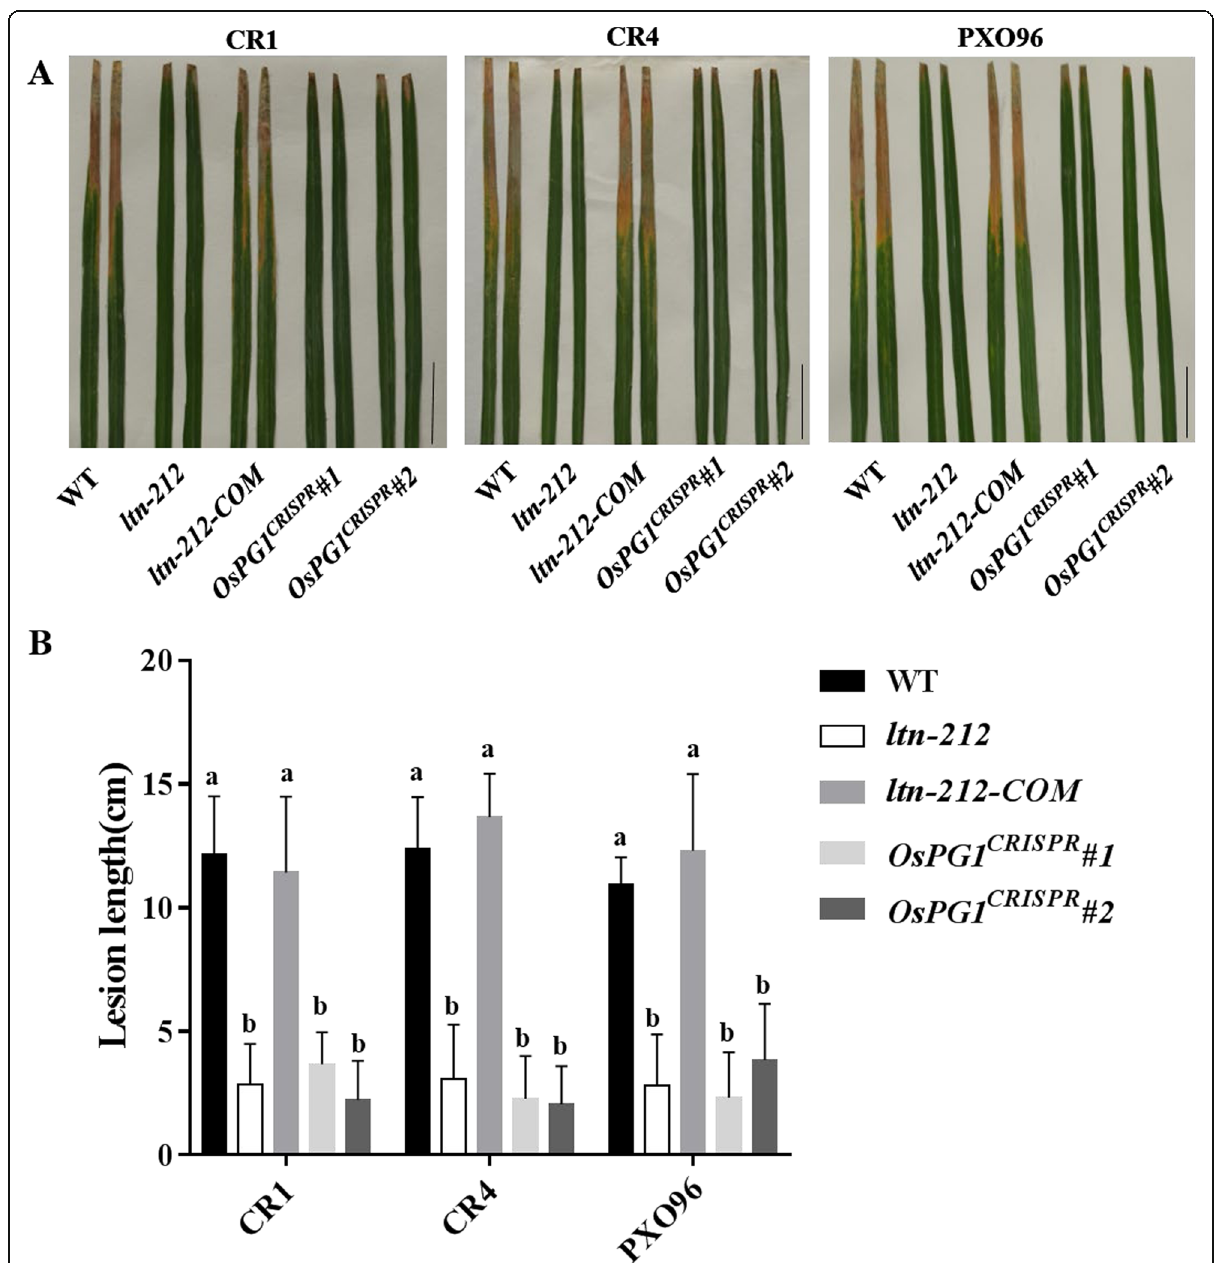
Fig. 7 Disease reactions of the WT, ltn-212 and transgene plants to Xoo . A. Disease symptoms of WT, ltn-212 , ltn-212-COM, OsPG1 CRISPR #1 , and OsPG1 CRISPR #2 leaves after Xoo inoculation at 15 days (scale bar = 5 cm). B. Lesion lengths measured at 15 days after inoculation with 3 different Xoo strains. Data are means ±SD of at least 15 leaves. a, b indicates significance at P ≤ 0.01 (Student ’ s t